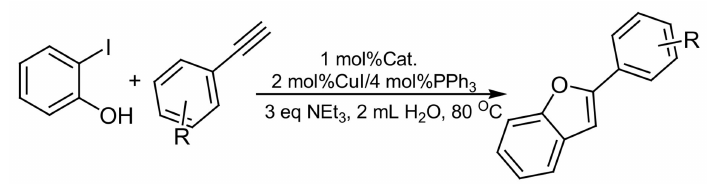
Scheme 1. 2-substituted benzo[b]furans